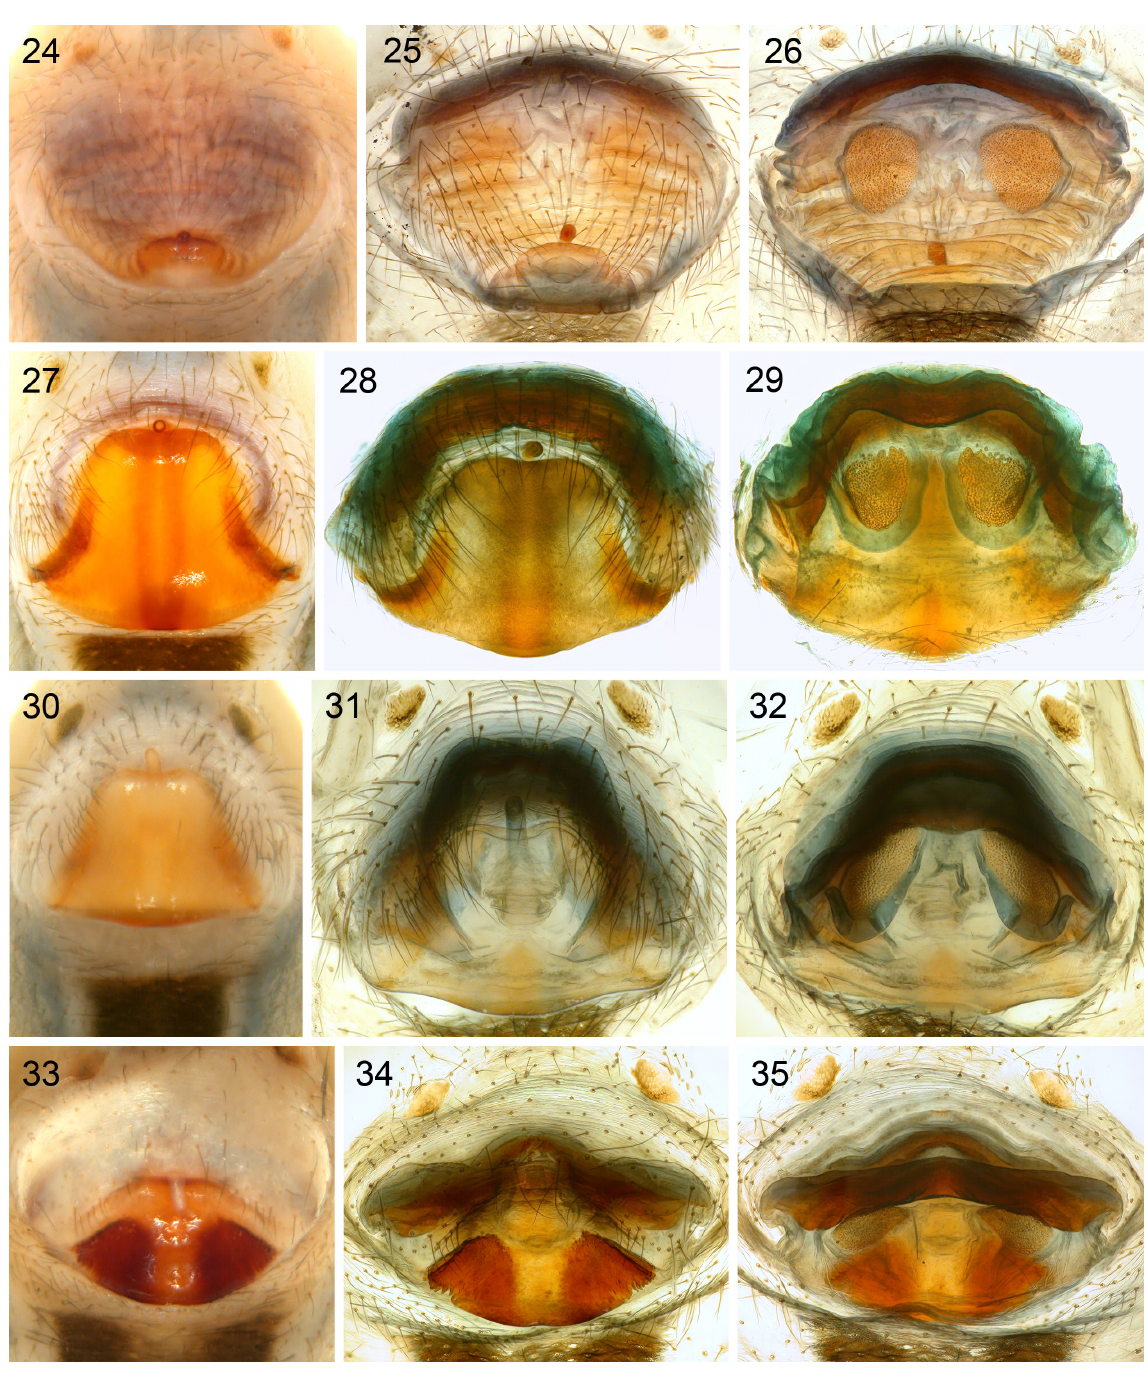
Figs 24–35. epigyna, ventral views, and cleared female genitalia, ventral and dorsal view. 24–26 . Pholcus olangapo Huber, sp. nov., ZFMK Ar 15498. 27–29 . Pholcus mulu Huber, sp. nov., ZFMK Ar 15502. 30–32 . Pholcus kawit Huber, sp. nov., ZFMK Ar 15505. 33–35 . Pholcus baguio Huber, sp. nov.,